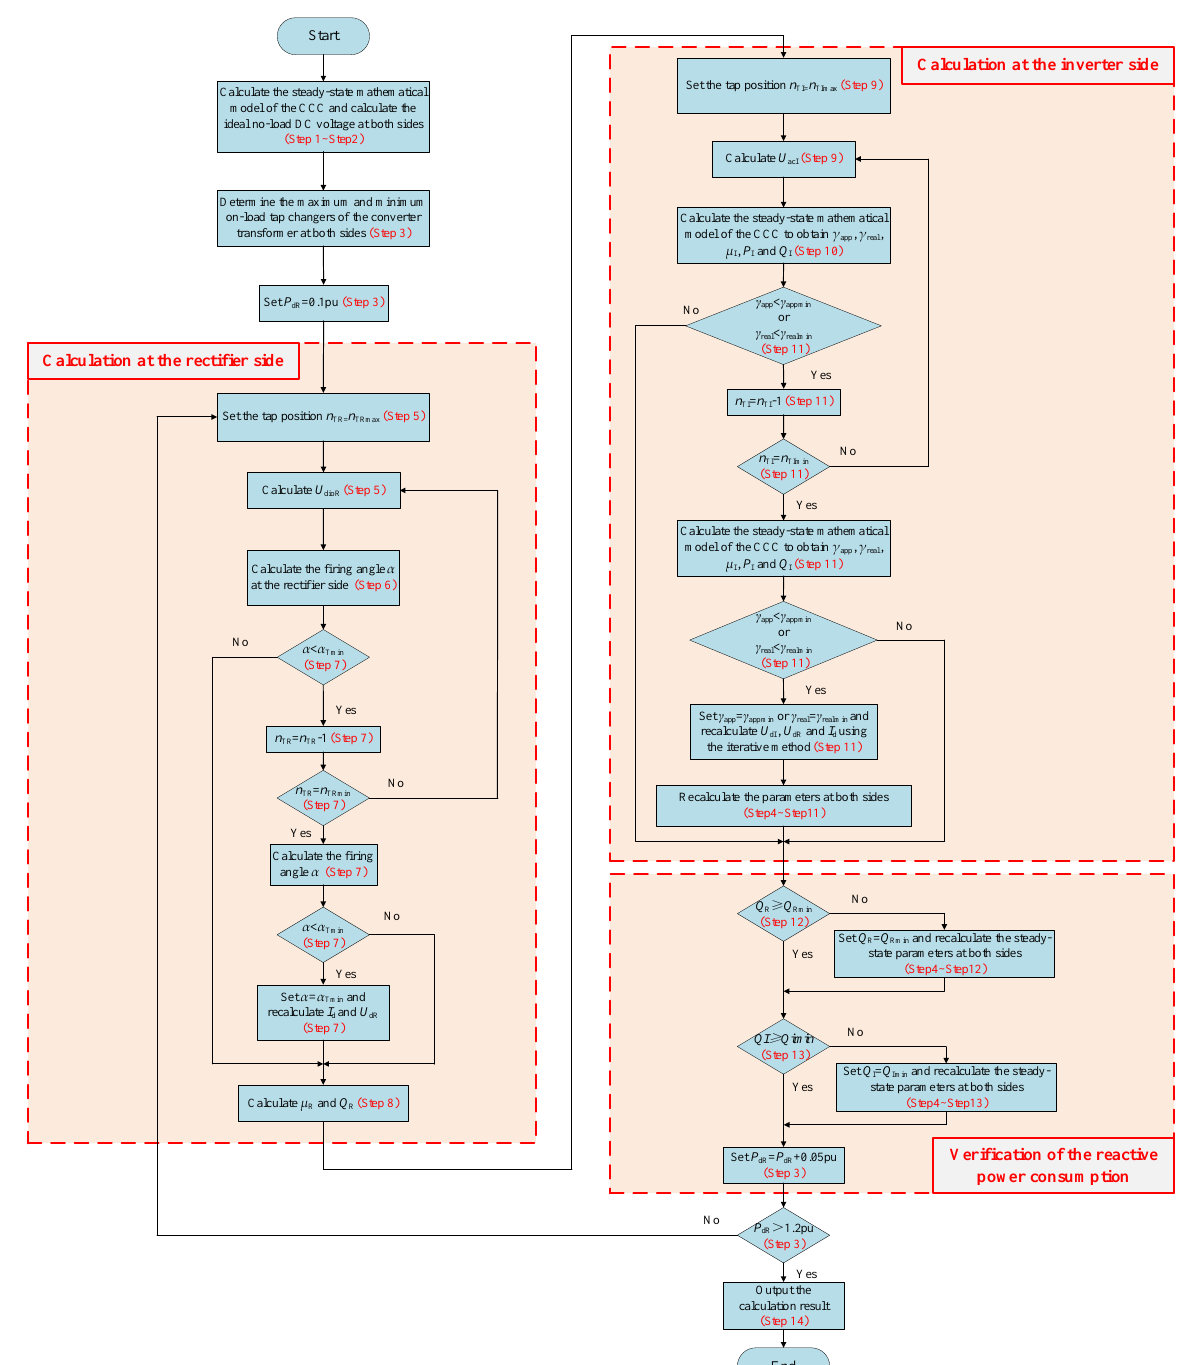
Figure 6. Flow chart of the detailed procedure for the main circuit parameter design.